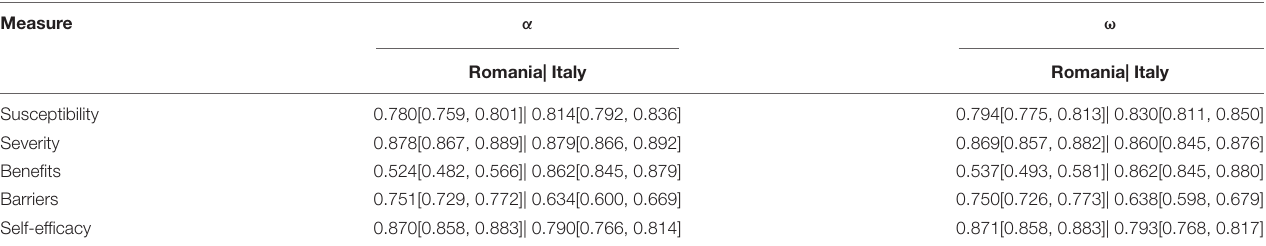
TABLE 2 | Reliability of the individual measures in Romania and Italy along with the corresponding 95% confidence intervals. Measure